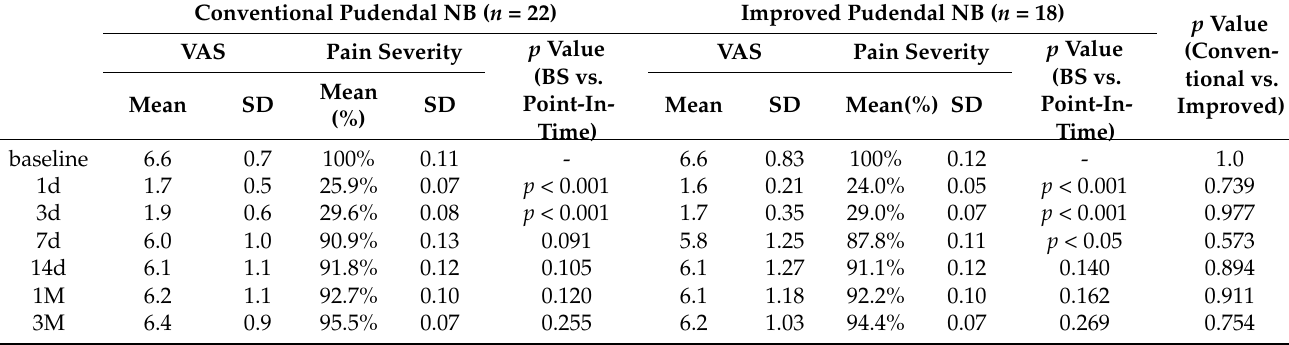
Table 2. Changes in VAS and pain severity between the conventional and improved pudendal NB groups and changes in VAS and pain severity from baseline in the conventional/improved